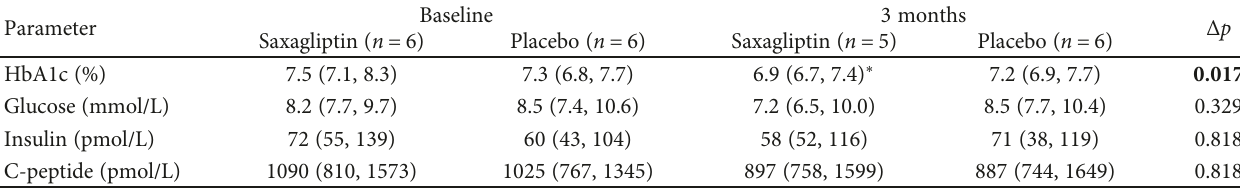
Table 2: Glucometabolic variables according to the randomized groups at baseline and after 3 months. Median (25, 75 percentiles) is given.